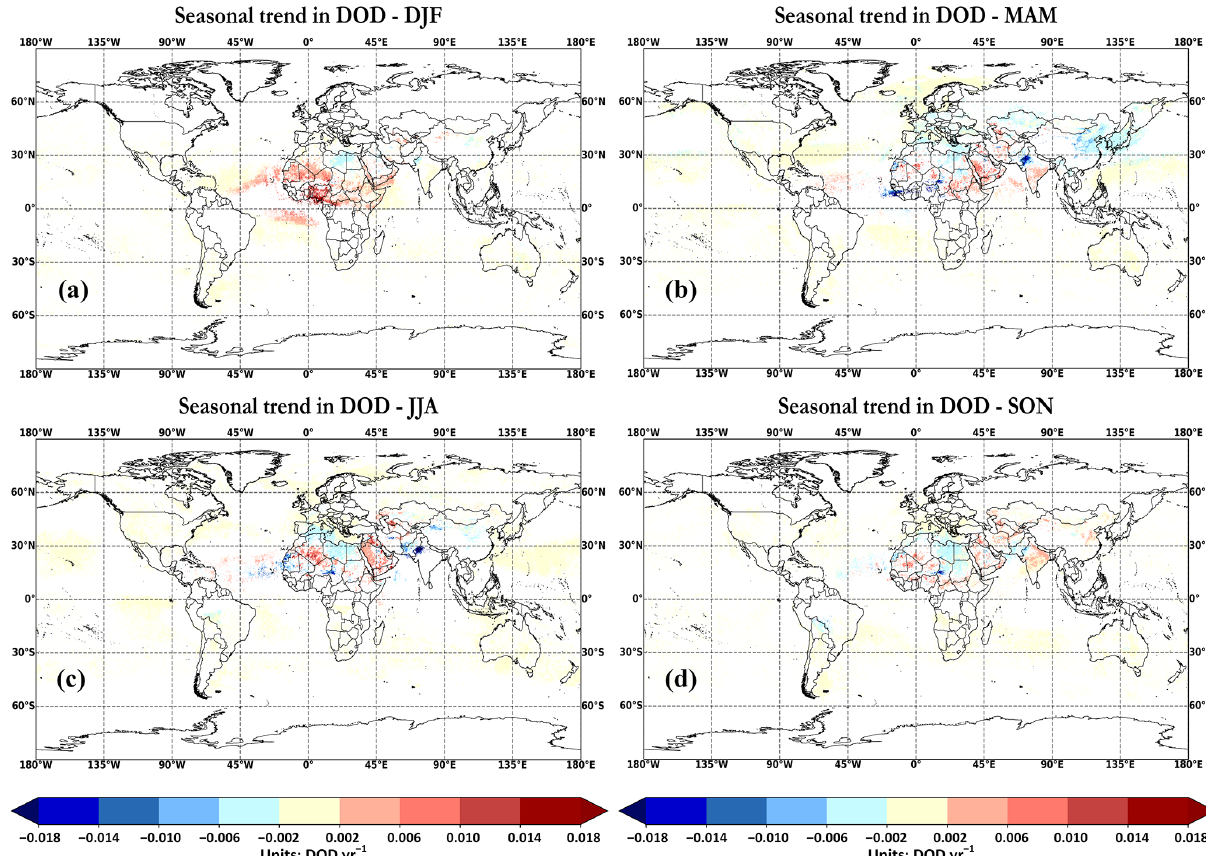
Figure 6. Seasonal geographical distributions of DOD temporal trends in (a) December–January–February (DJF), (b) March–April–May (MAM), (c) June–July–August (JJA) and (d) September–October–November